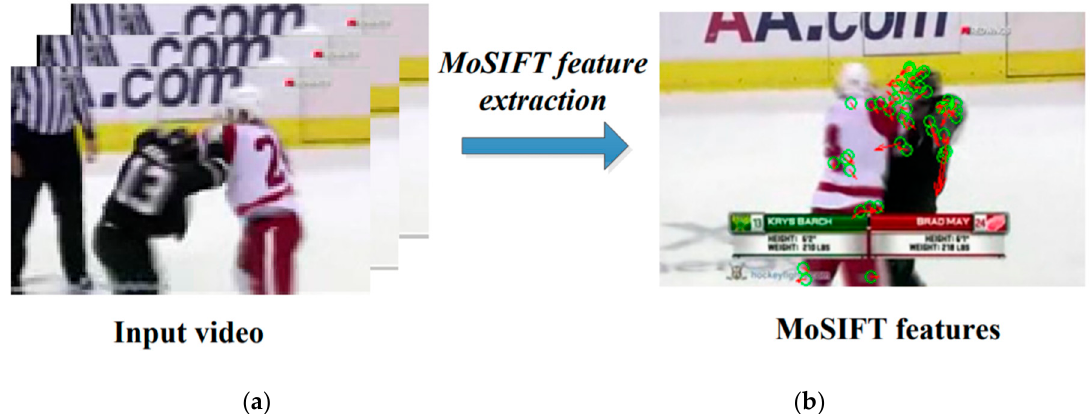
Figure 3. (a ) image prior to MoSIFT points; ( b ) image with MoSIFT points extracted [13]. Figure 3. ( a ) image prior to MoSIFT points; ( b ) image with MoSIFT points extracted